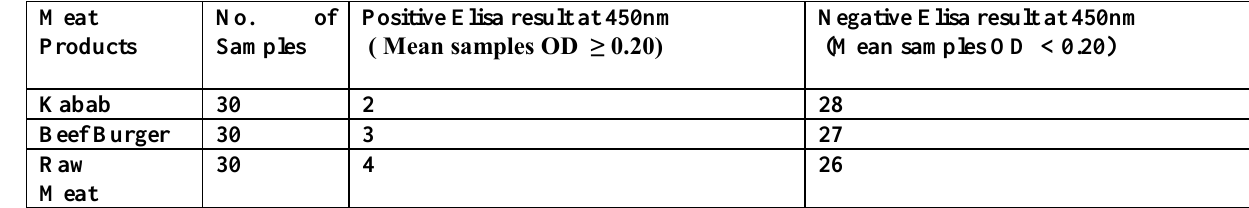
Table 1: Shows the results of ELISA testing